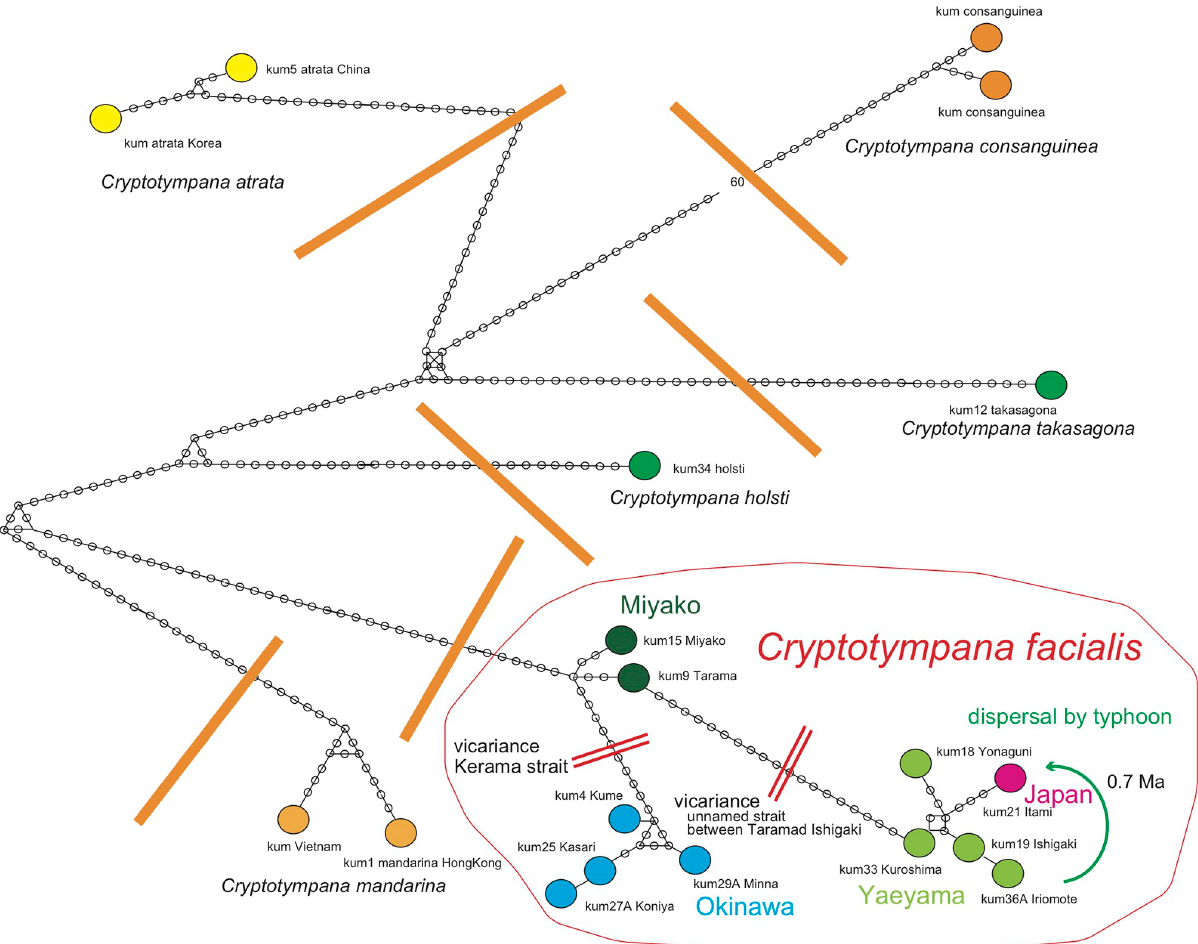
Fig 7. Haplotype network of Cryptotympana . C . facialis was vicariantly speciated due to isolation of island groups of Okinawa, Miyako, and Yaeyama, separated by major straits (red double line) formed since 1.55 Ma, and three island group haplotypes or populations were formed. However, the Japan haplotype was included in the Yaeyama haplotype network, suggesting a long-distance dispersal (green curved arrow) from Yaeyama (southern end of Ryukyu) to Japan at 0.58 Ma (Fig 6), crossing Miyako and Okinawa. Orange heavy line: C . facialis is separated by the other Cryptotympana species including C . takasagona